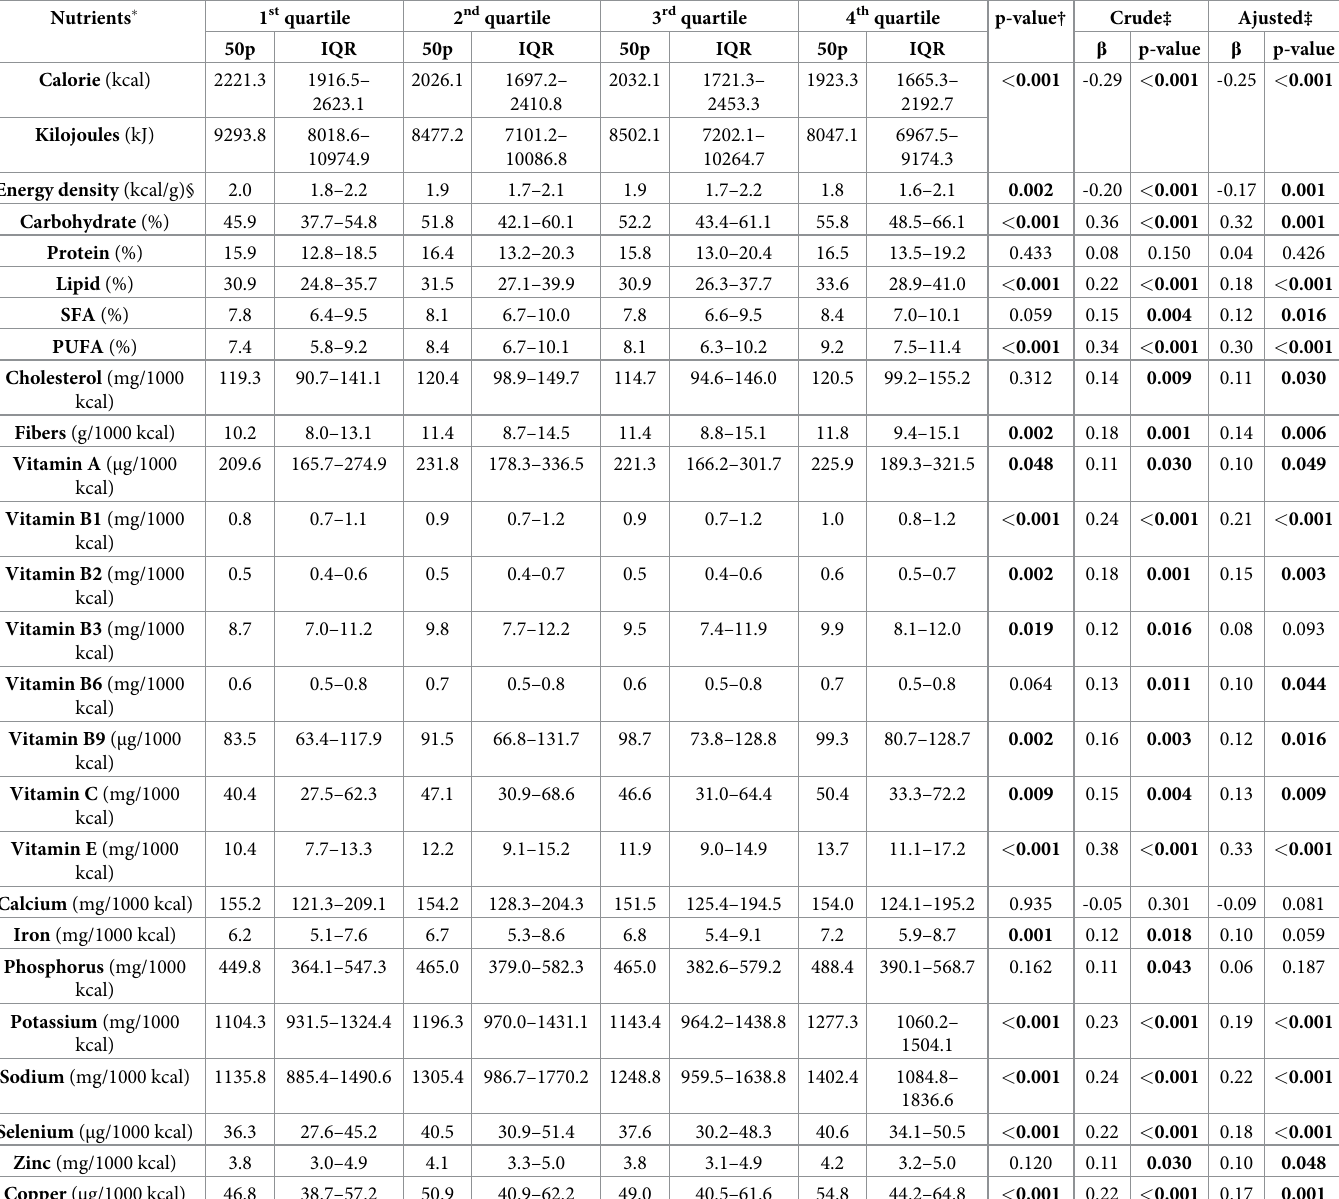
Table 5. Diet’s nutritional profile according to the caloric contribution of the consumption of processed culinary ingredients by Brazilian